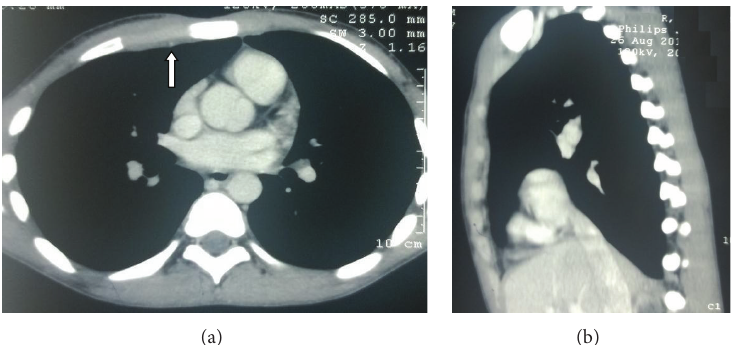
Figure 5: (a) Axial CECT image at lesion level in mediastinal window after 4 months of treatment showing considerable decrease in the collection with no peripheral enhancement. (b) The reconstructed CECT coronal image of the same